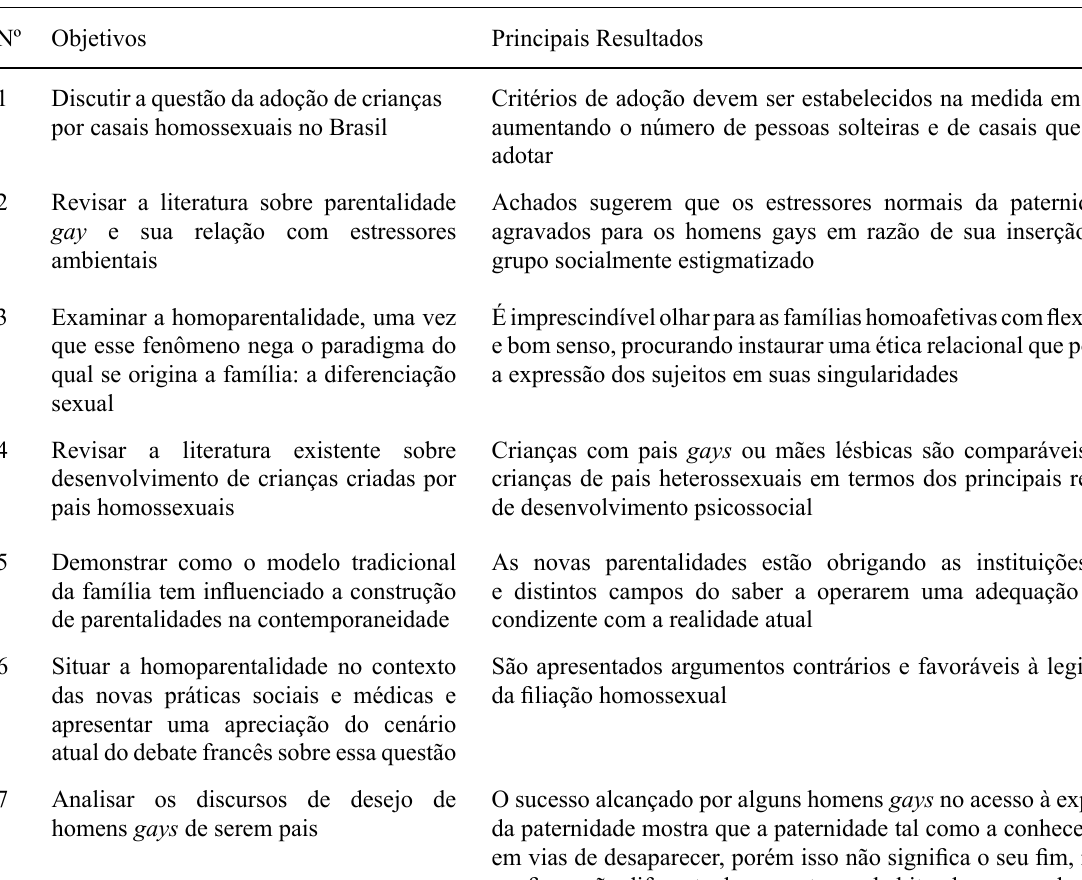
Tabela 2 Objetivos e Principais Resultados dos Estudos Recuperados (n =